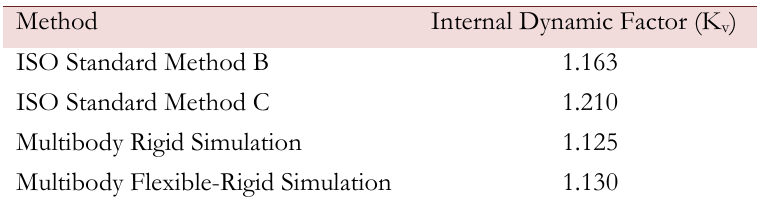
Table 3: K v values for Gear